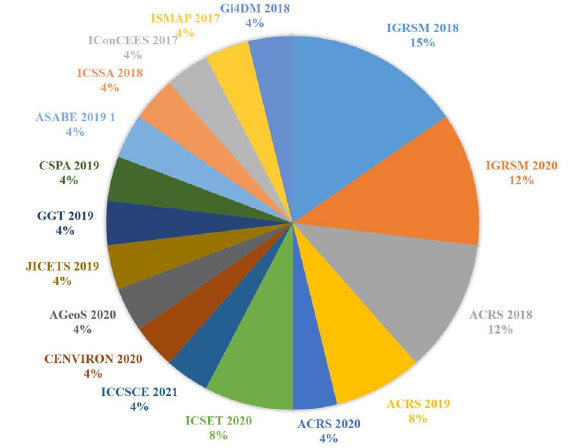
Figure 4 . Contribution of conferences.